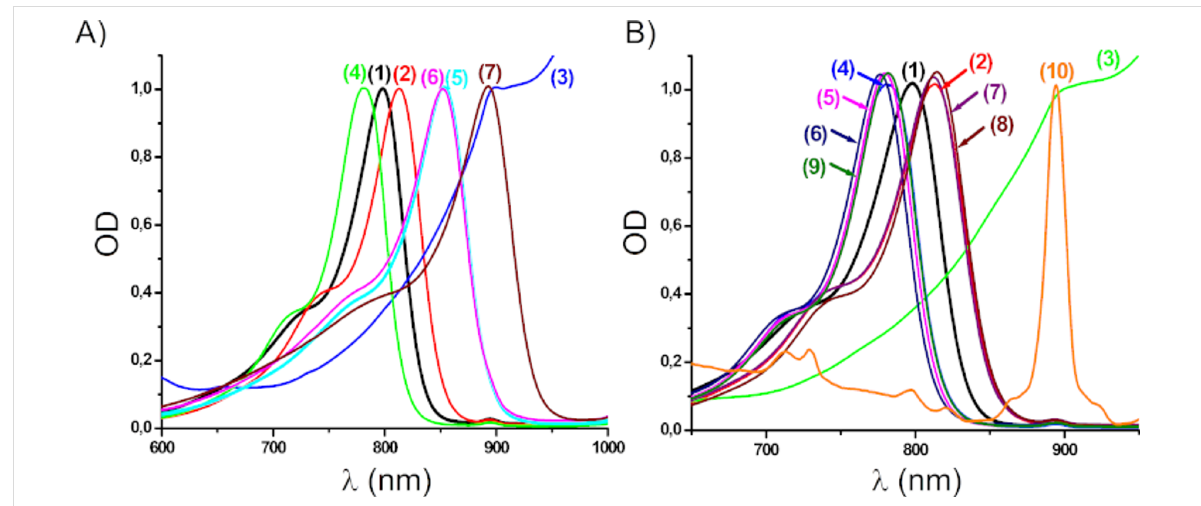
Figure 1: Visible–NIR spectra of NIR dyes in ACN. A) (1) CBPh1 , (2) CBPh2 , (3) CBPh3 , (4) CBPh4 , (5) Ca , (6) Cb , and (7) CNa . B) (1) CI1 , (2) CI2 , (3) CI3 , (4) CI4 , (5) CI5 , (6) CI6 , (7) CI7 , (8) CI8 , (9) CI9 , and (10) CI10 .